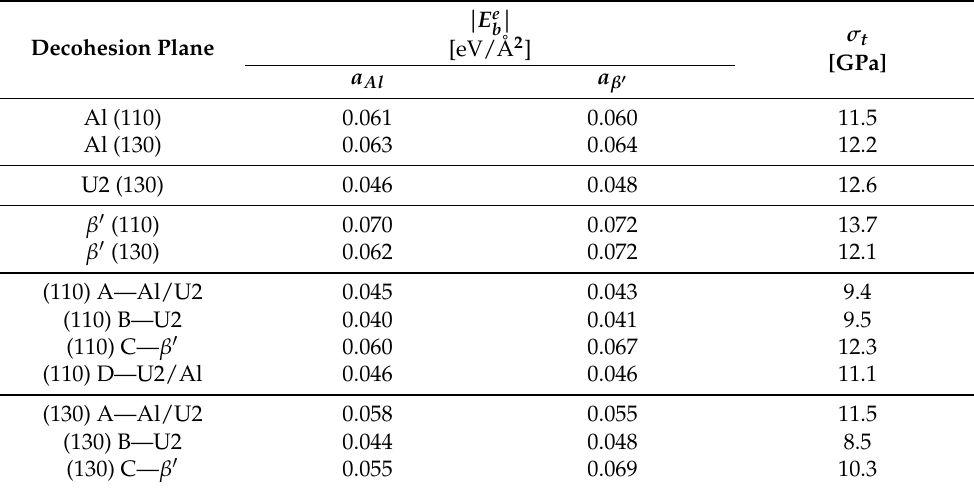
Table 3. Decohesion energy and theoretical strength of the different interfaces investigated with a and b in the β (cid:48) unit cell either from relaxed bulk Al ( b Al ) or relaxed bulk β (cid:48) ( b β (cid:48) ).